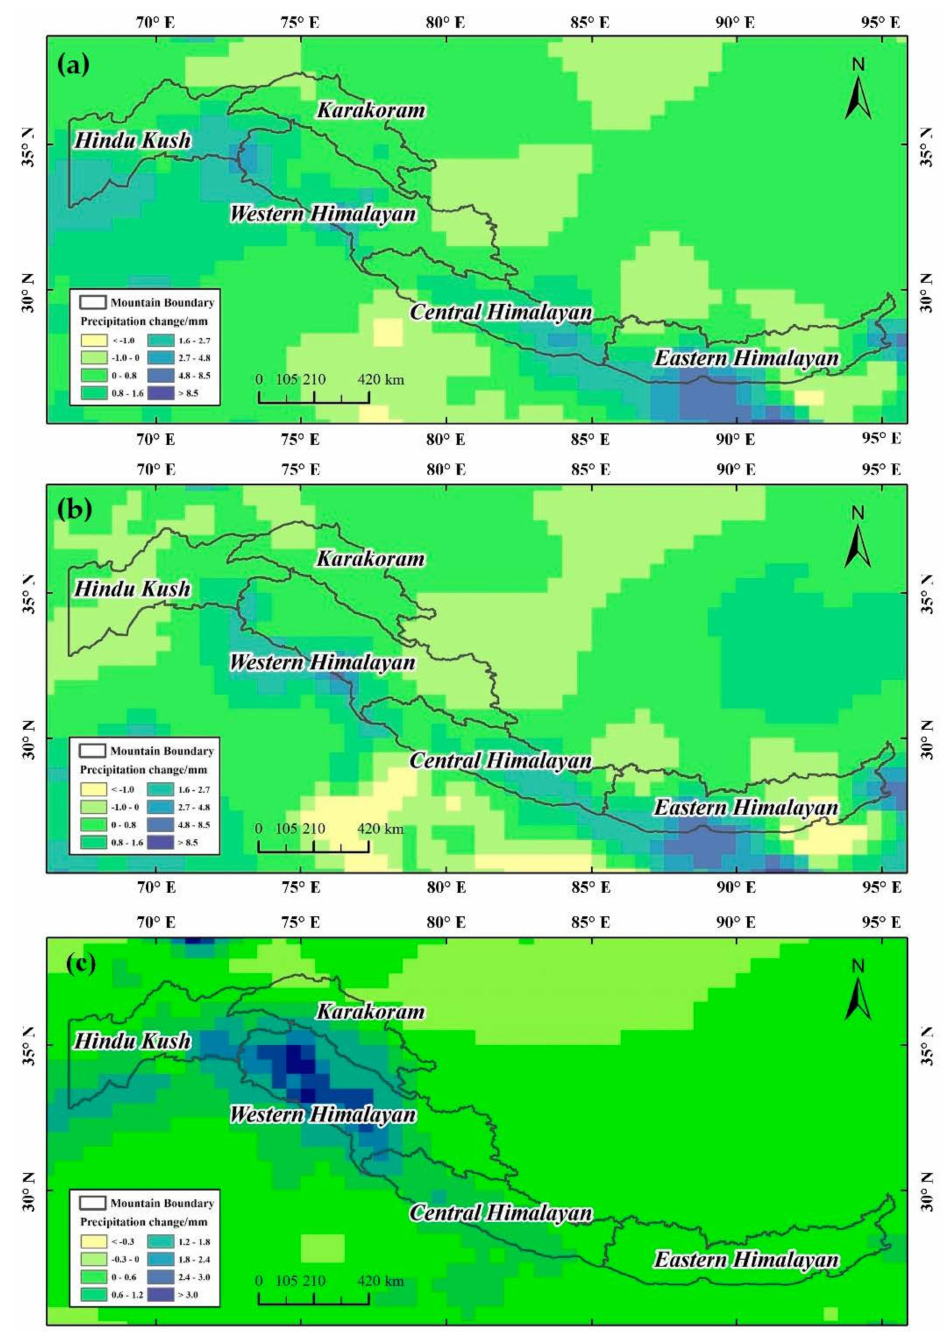
Figure 14. Precipitation changes for in the HKH-TMHA region: ( a ) changes in annual daily precipita- tion, ( b ) changes in summertime daily precipitation, and ( c ) changes in wintertime daily